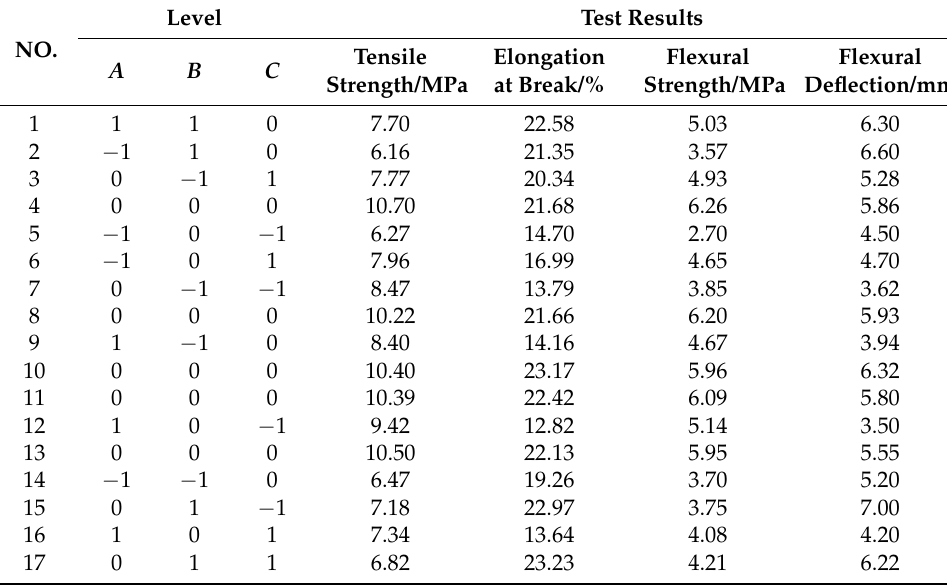
Table 2. Response surface test design and test